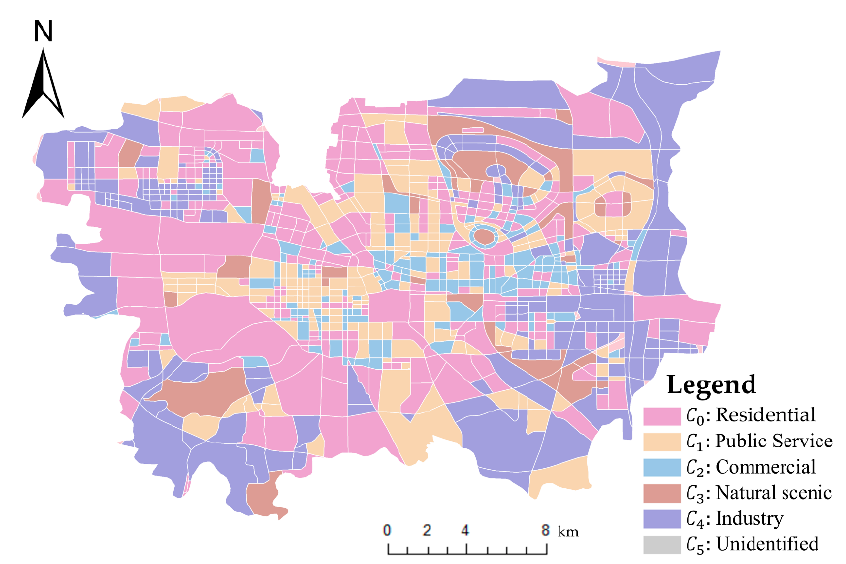
Figure 9. Identification results of urban functional areas in the main areas of Zhengzhou. Note: Public Service in the legend is Science, Education and Public Service areas . Table 4. CR and EF values of POIs.